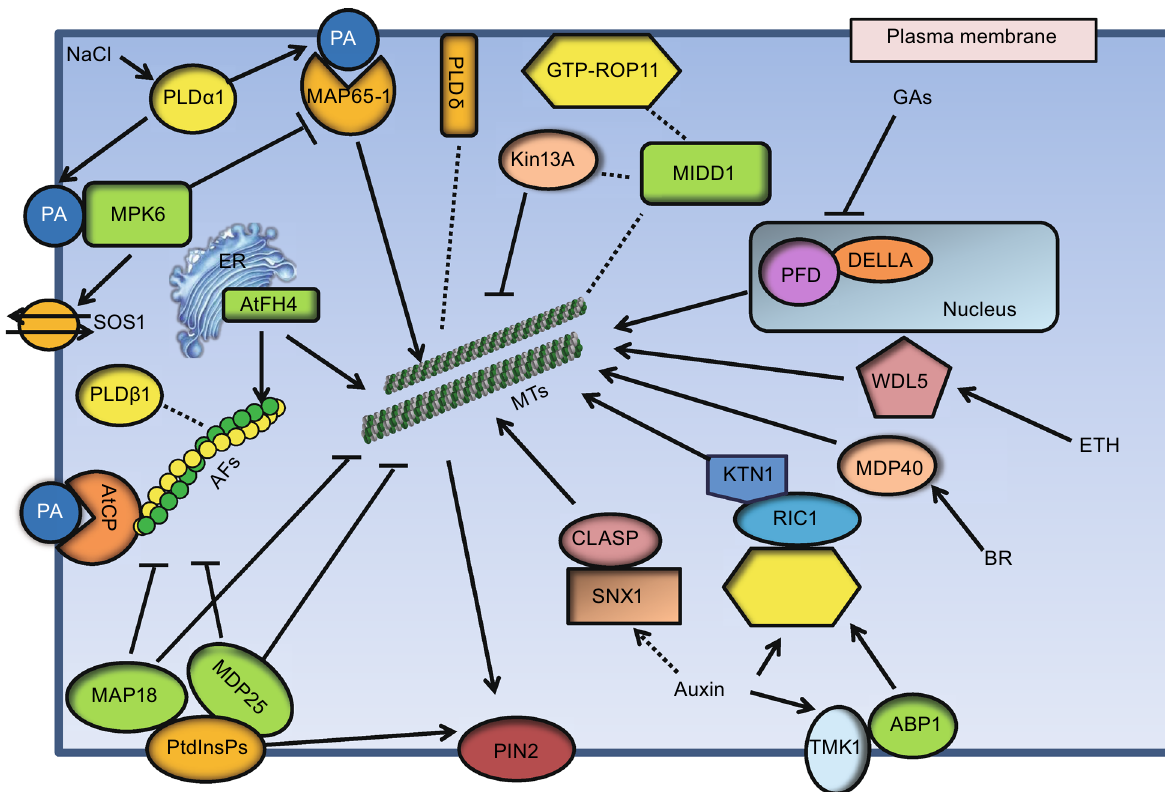
Figure 1. Model of cortical microtubule organization regulated by membrane-associated proteins and lipids in response to plant hormones and stress. Activation of PLD α 1 by salt stress leads to production of PA, which binds to MAP65-1 and MPK6 to regulate microtubule organization and the SOS pathway, respectively. PA also binds to AtCP to modulate actin fi laments. The PtdInsPs-binding proteins, MAP18 and MDP25, negatively regulate cytoskeletal organization. Plasma membrane-localized TMK1 interacts with ABP1 and transduces auxin signals to activate plasma membrane-associated ROPs leading to changes in the cytoskeleton and the shape of leaf pavement cells. Locally activated ROP11 recruits MIDD1 to plasma membrane domains. MIDD1 links plasma membrane, cortical microtubules, and Kin13A. CLASP regulates levels of the auxin ef fl ux carrier PIN2 by tethering SNX1 endosomes to cortical microtubules, which fi ne tunes auxin maxima in the root apical meristem. In the absence of GA, DELLA retains PFD in the nucleus, and in the presence of GA, DELLA proteins are degraded, which allows PFD to move to the cytoplasm leading to increased production of tubulin dimers. WDL5 and MDP40 act as important mediators in regulating microtubule organization in response to ETH and BR signals, respectively. ER, endoplasmic reticulum; MTs, microtubules; AFs, actin